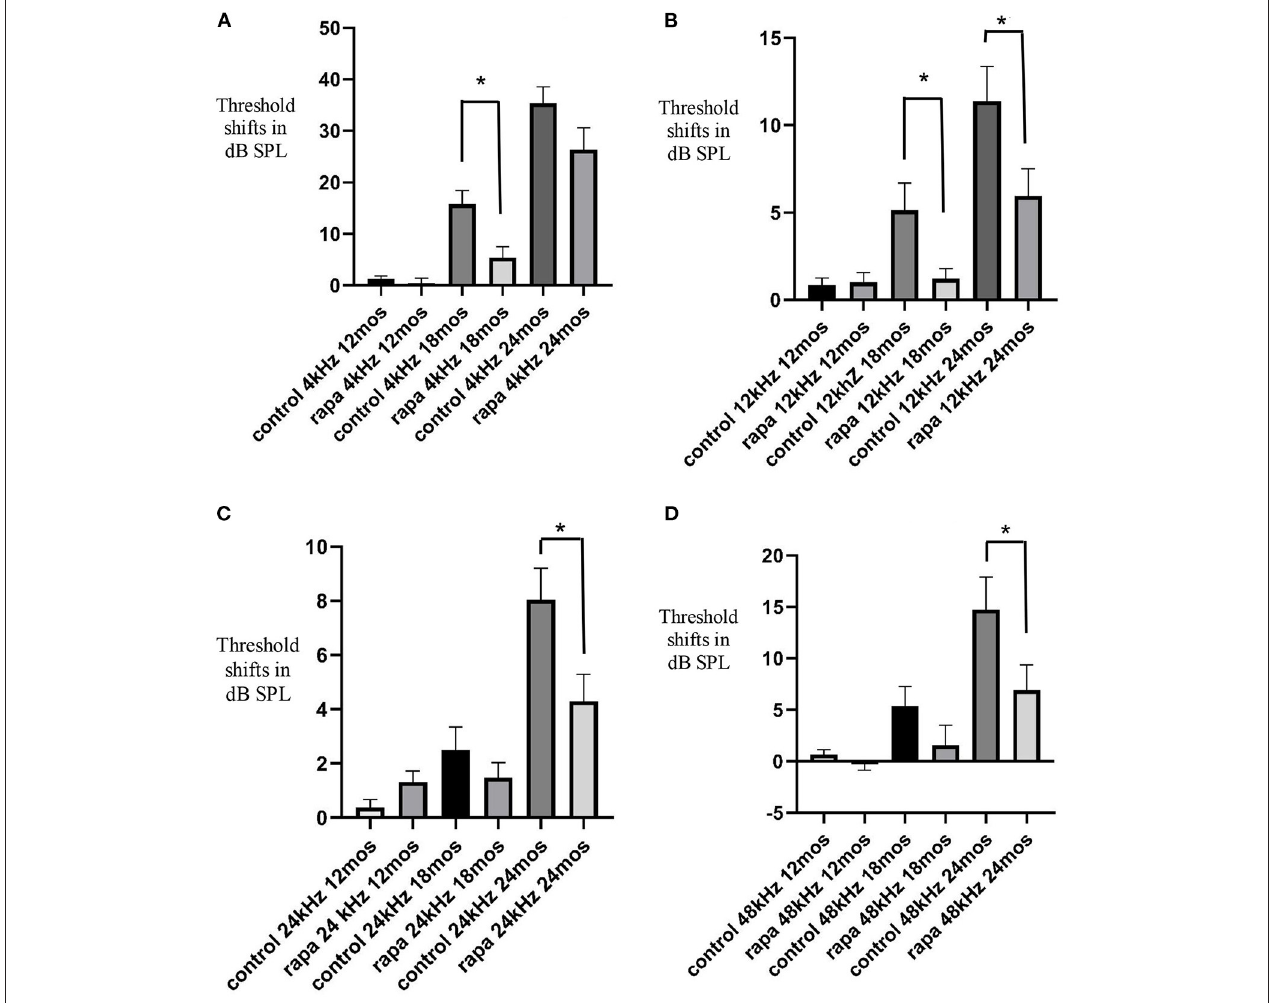
FIGURE 1 | Comparison of mean auditory brain stem response threshold shifts (compared to 5 months of age) in the group with rapamycin added to diet at 14 months of age (rapa) vs. the group on control diet without rapamycin (control) at 12, 18, and 24 months of age at 4kHz (A) , 12kHz (B) , 24kHz (C) and 48kHz (D). Asterisks indicate significant differences. Please note differences between A, B, C, and D in scale bars for dB SPL on the “y” axis.